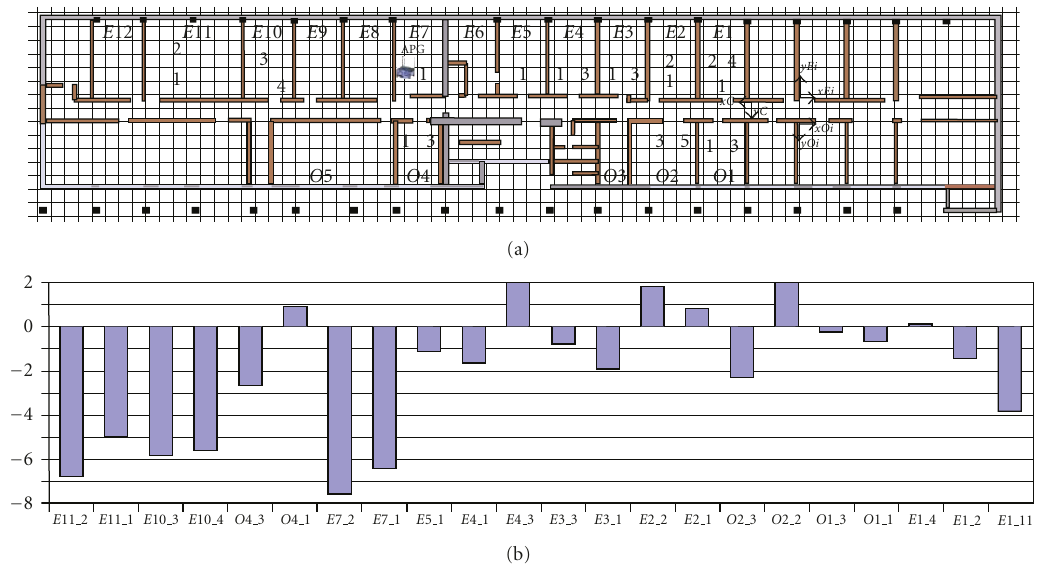
Figure 7: Map of indoor polarization measurements and average power balance (in dB) between vertical and horizontal polarizations at receiving points.